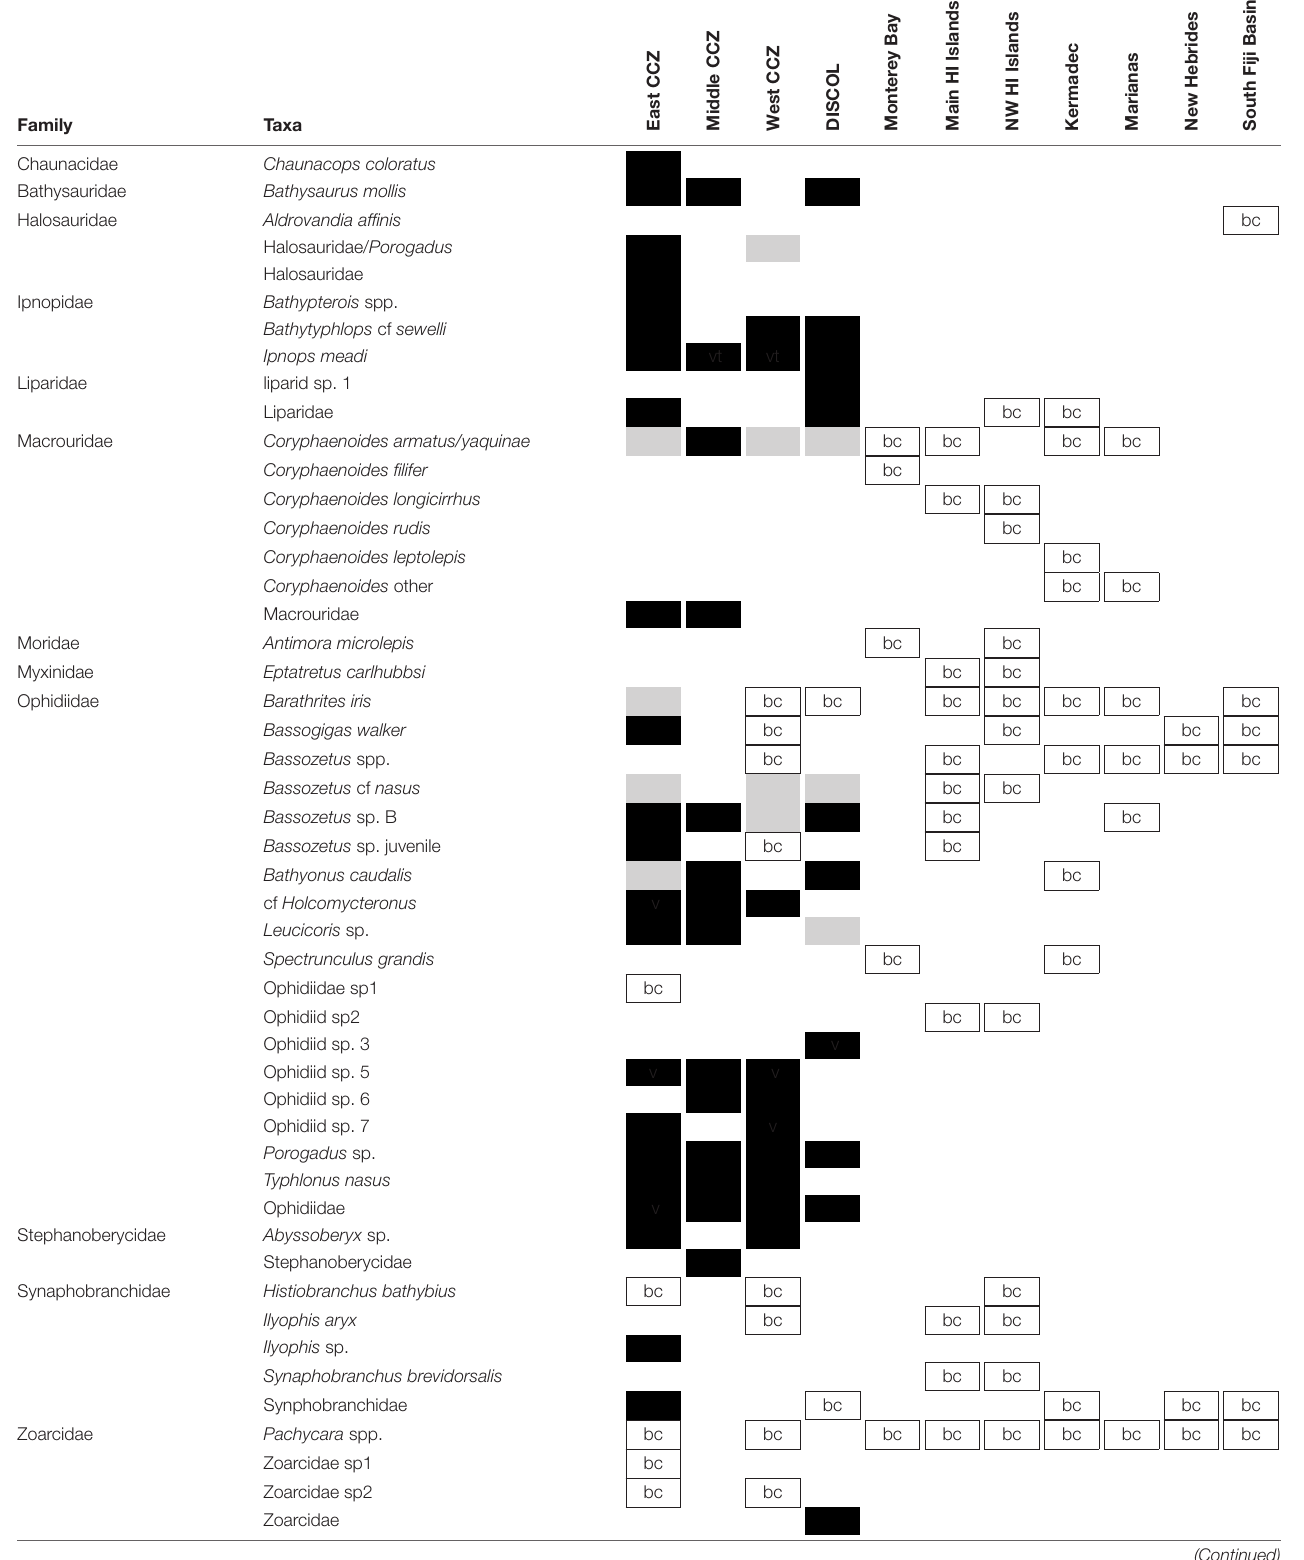
TABLE 4 | Presence and absence of fishes and scavengers observed in visual transects (black cells), baited camera deployments (white cells with “bc”), or both (gray cells).